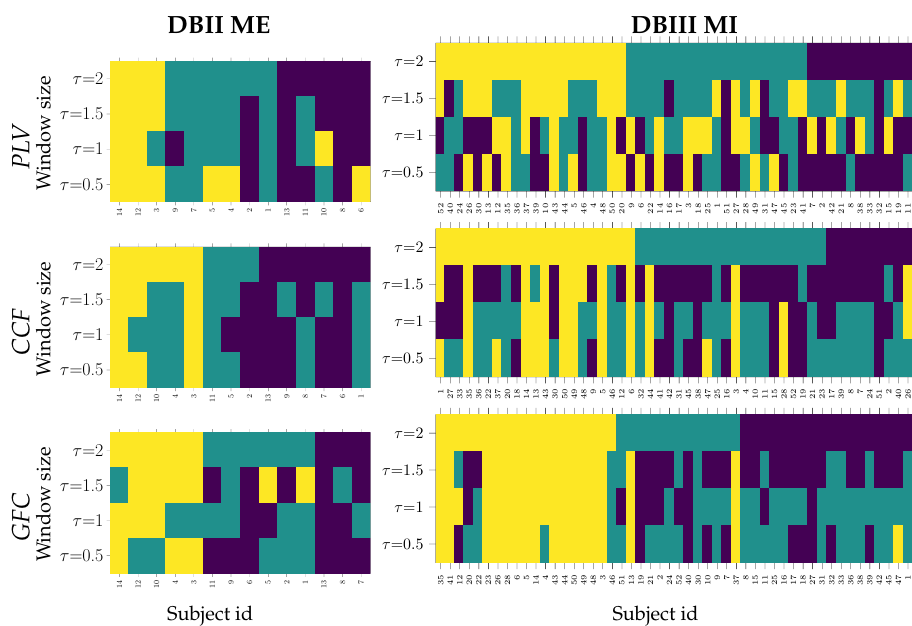
Figure 4. Clustering variability of individuals that belong to Group I (cells in yellow), Group II (Turquoise), and Group III (purple), depending on the extracting window length τ